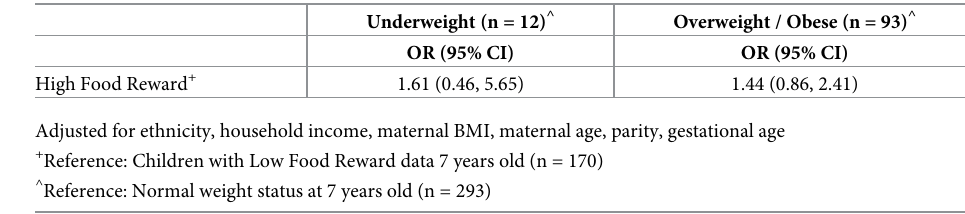
Table 4. Associations between food reward at 6 years old and child adiposity at 7 years old (n = 398).